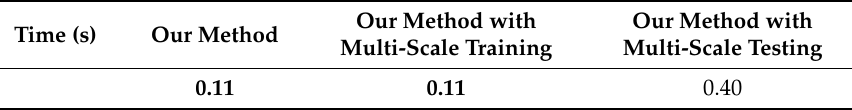
Table 9. The average running time of the object detection